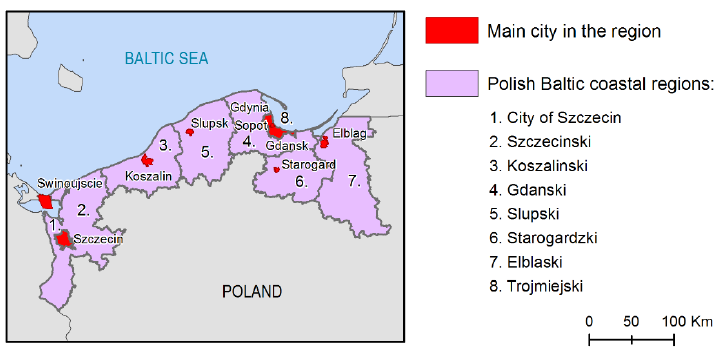
Figure 1. The Polish Baltic coastal zone. Figure 1 . The Polish Baltic coastal zone.